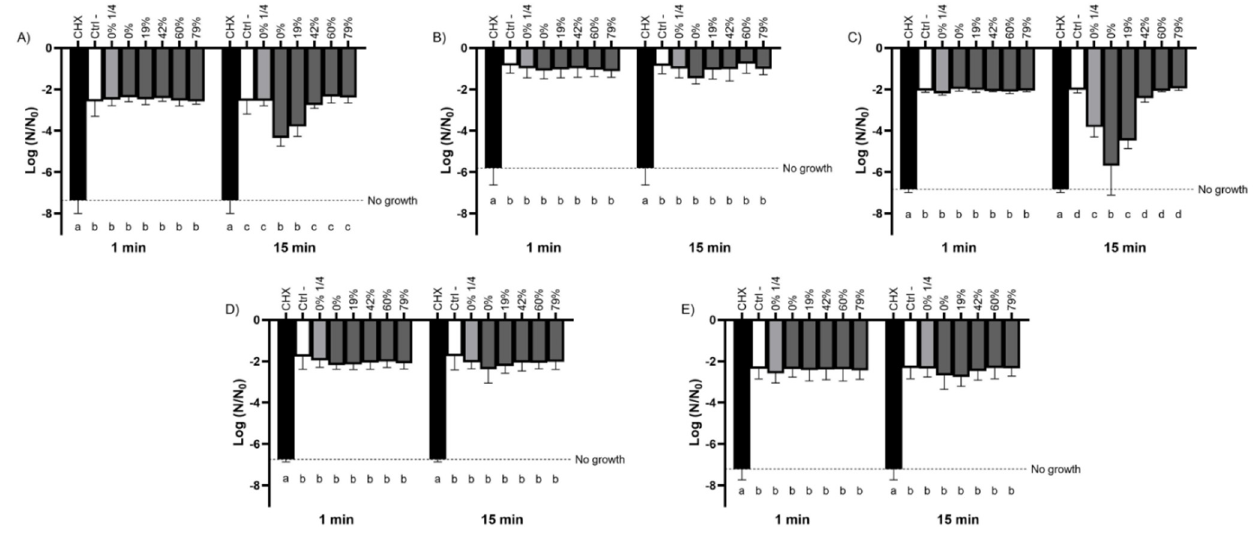
Figure 1. Effect of the deacidification rate (0, 19, 42, 60, and 79%) of cranberry juice on the viability of planktonic oral streptococci reported as log of the initial bacterial count (N 0 ) following 1-min and 15-min contacts. The effect of a ¼ dilution of raw CJ on bactericidal activity was also studied. ( A ) S. mutans , ( B ) S. sobrinus , ( C ) S. gordonii , ( D ) S. oralis , and ( E ) S. salivarius . Results are expressed as mean log (N/N 0 ) ± SD of triplicate assays from two independent experiments. Columns with different letters are significantly different from one another (Two-way ANOVA, Bonferroni test, p < 0.01). CHX: Chlorhexidine 0.12%. Ctrl: Dilution buffer.